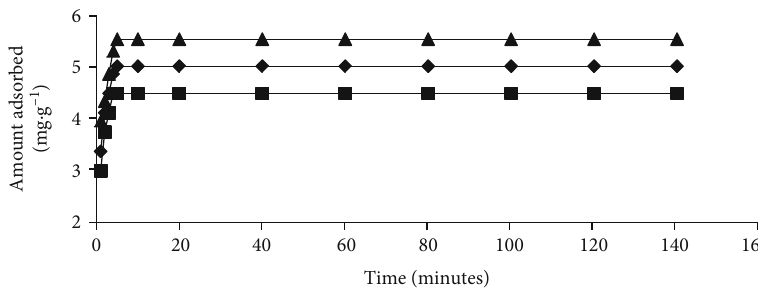
Figure 8: Adsorption kinetic plot of M.B on the surface of BTW at di ff erent